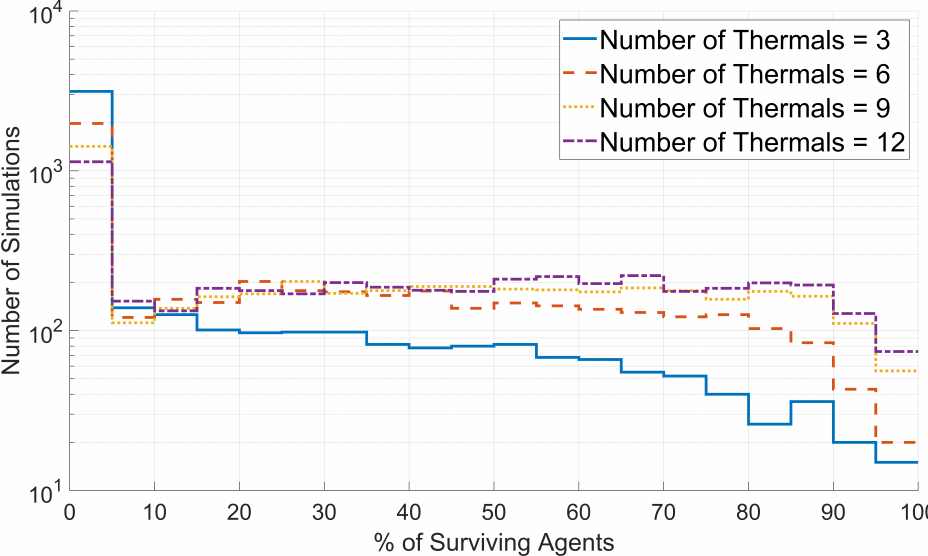
Figure 13. Distributions of swarm survival for simulations with 3, 6, 9, and 12 thermal updrafts. The number of simulations for a given percentage of surviving agents is plotted on a logarithmic